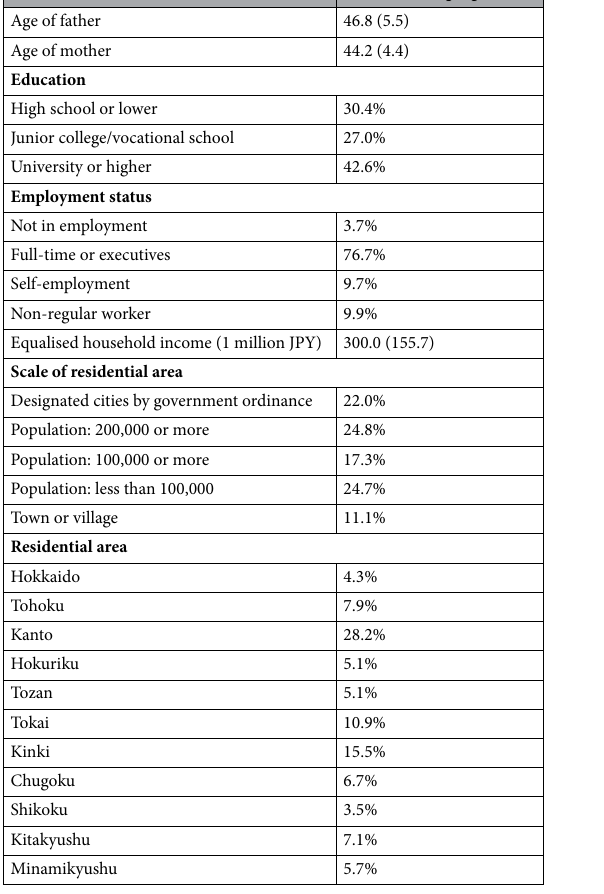
Table 2. Descriptive statistics for parents and households.